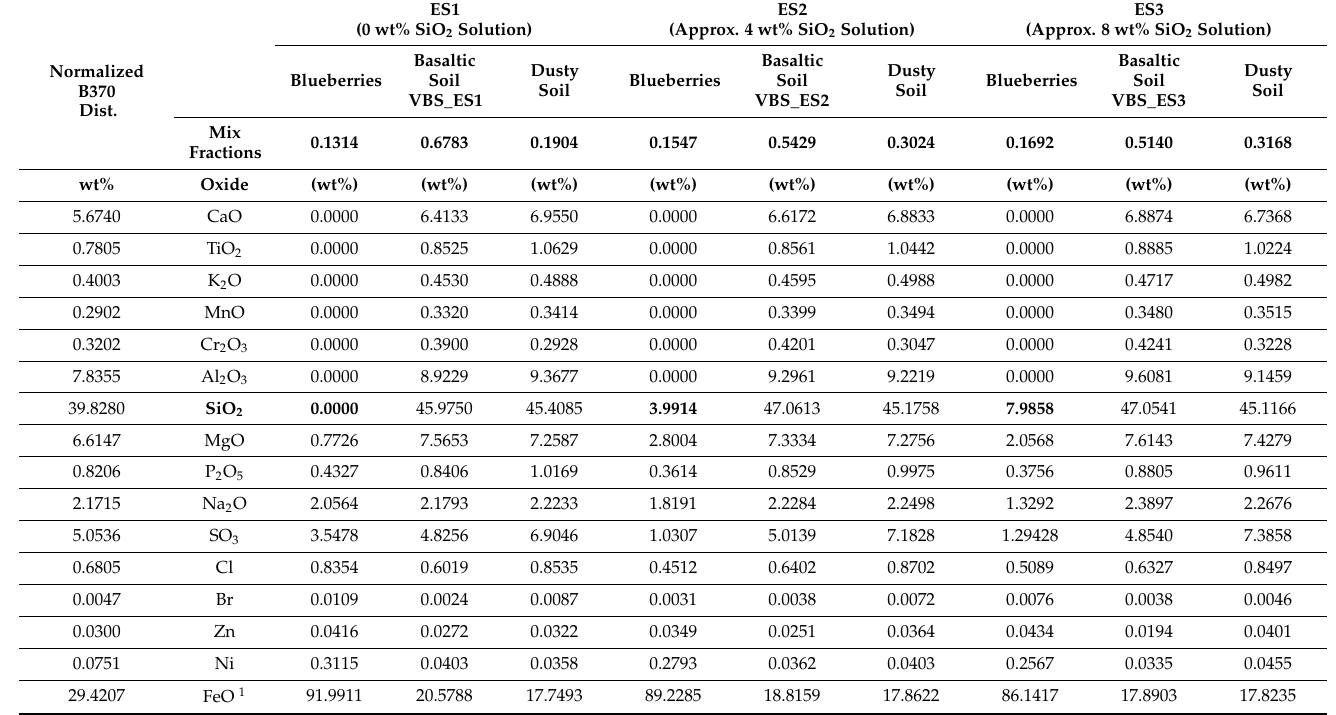
Table 4. Three Example Solutions of Mass-Balance Demixing (Equation (1)) of Mixed-Material Distribution